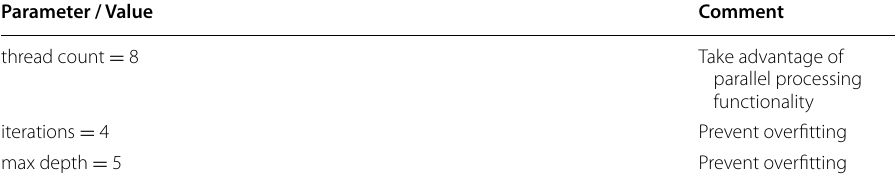
Table 5 CatBoost classifier hyper-parameters